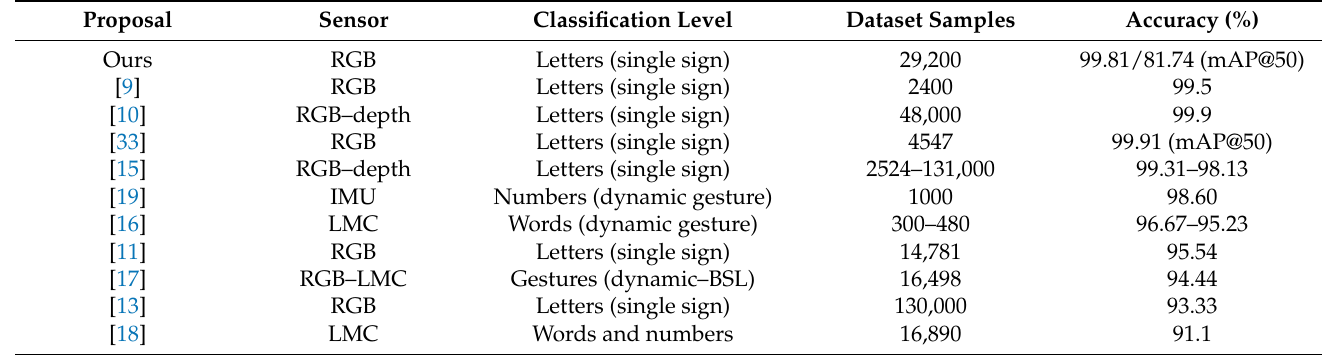
Table 6. Comparison of the proposed translator with state-of-the-art gesture recognition approaches. Note that not all works are based on visual